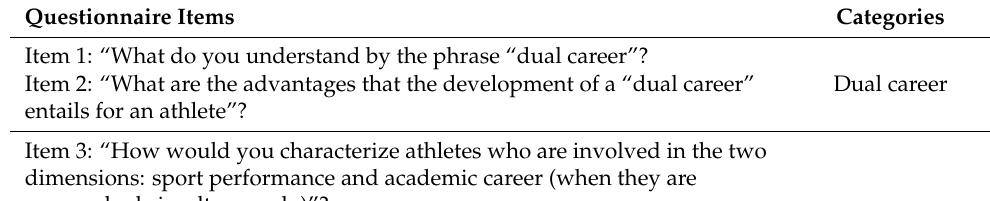
Table 1. Questionnaire items and categories. Questionnaire